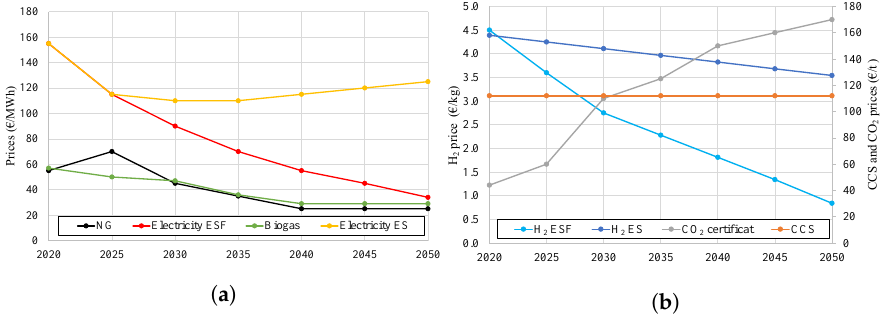
Figure 5. Price forecasts for ( a ) NG, electricity and BG and ( b ) hydrogen, CCS and CO 2 certificates.